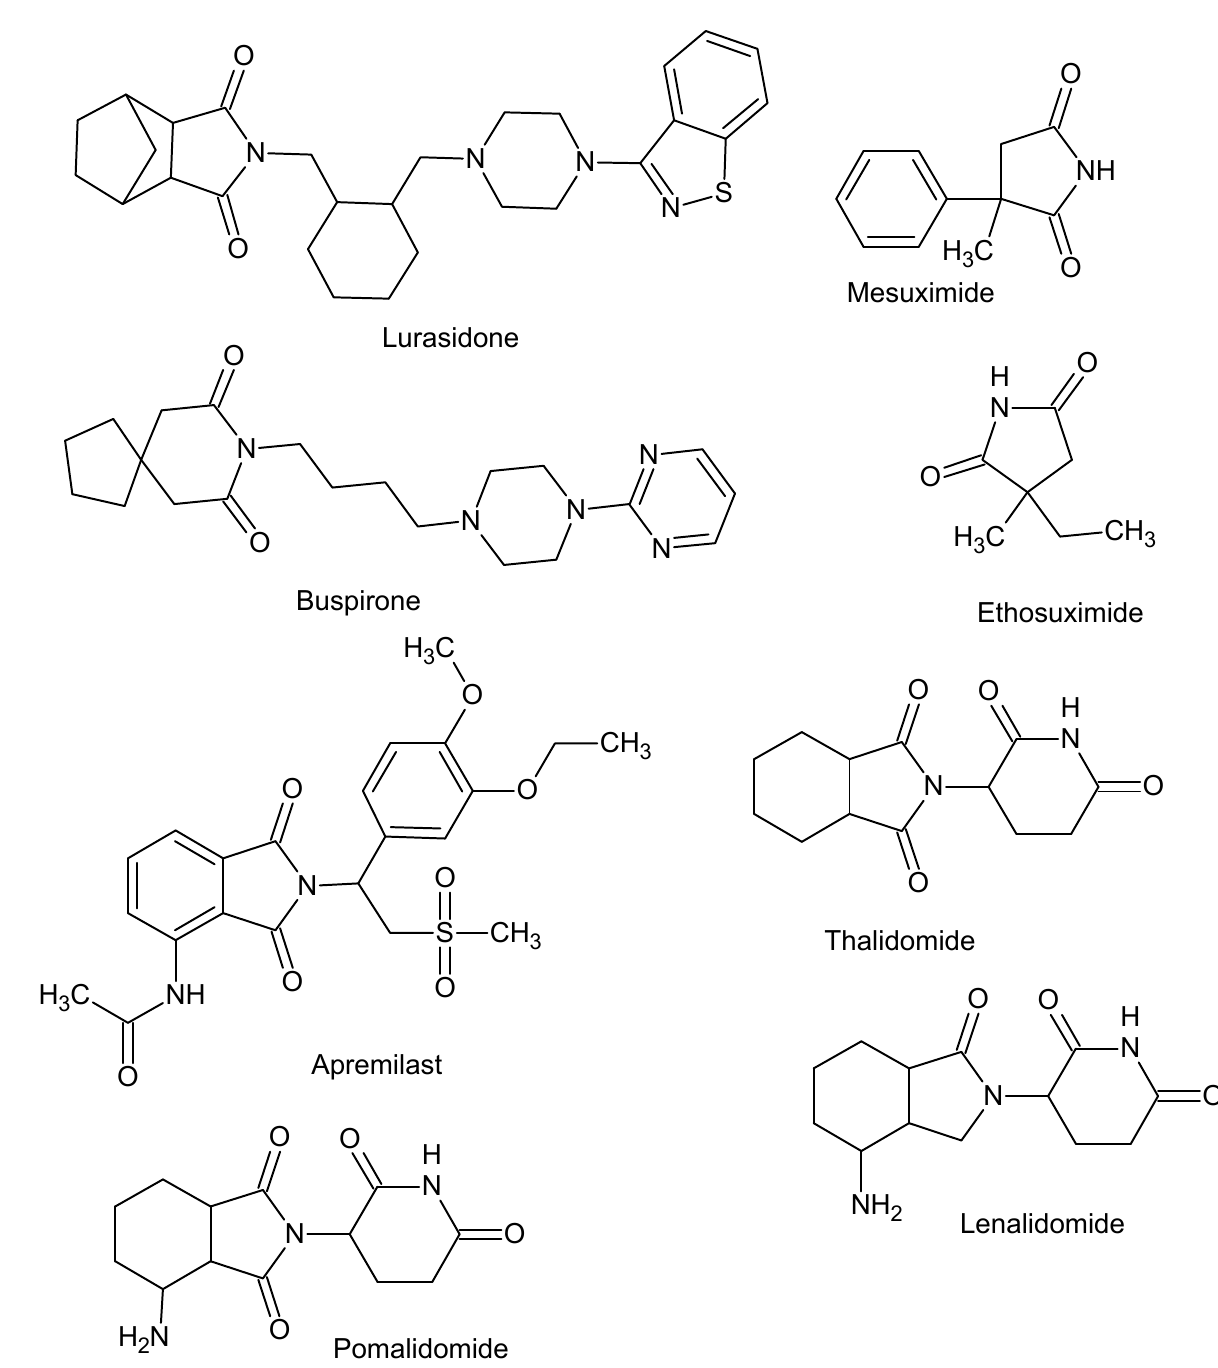
Figure 1. Drugs with cyclic imide structure.